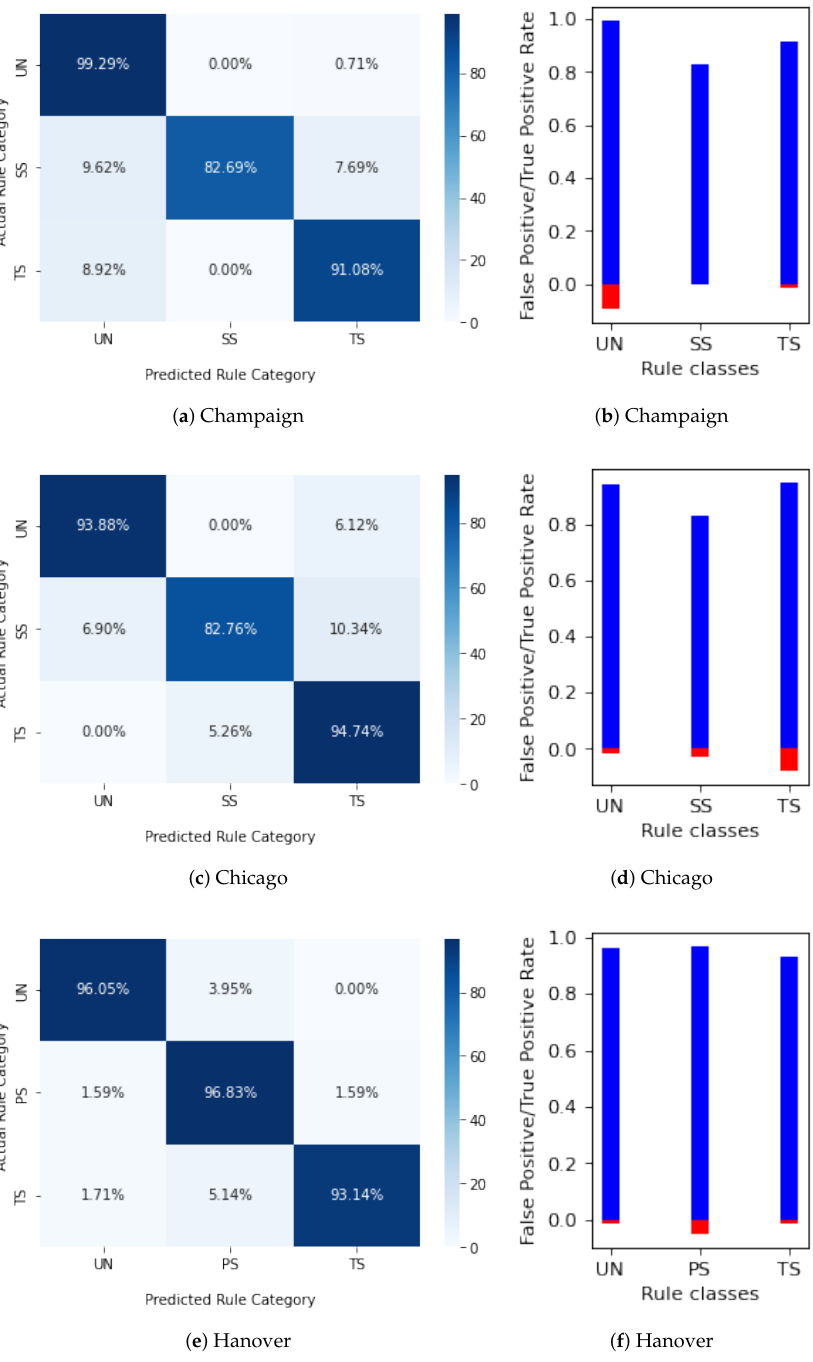
Figure 11. Confusion matrices and false/true positive rates for the three